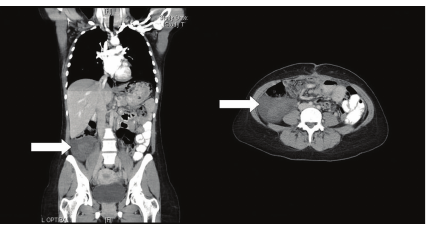
Figure3:Frontal( leftpanel )andtransverse( rightpanel )viewsofthe CT scan performed postoperatively. A well-defined oval hypodense uniform mass is appreciated at the right iliac fossa measuring 10 × 8.4 cm with a central rounded higher density soft tissue area within it (white